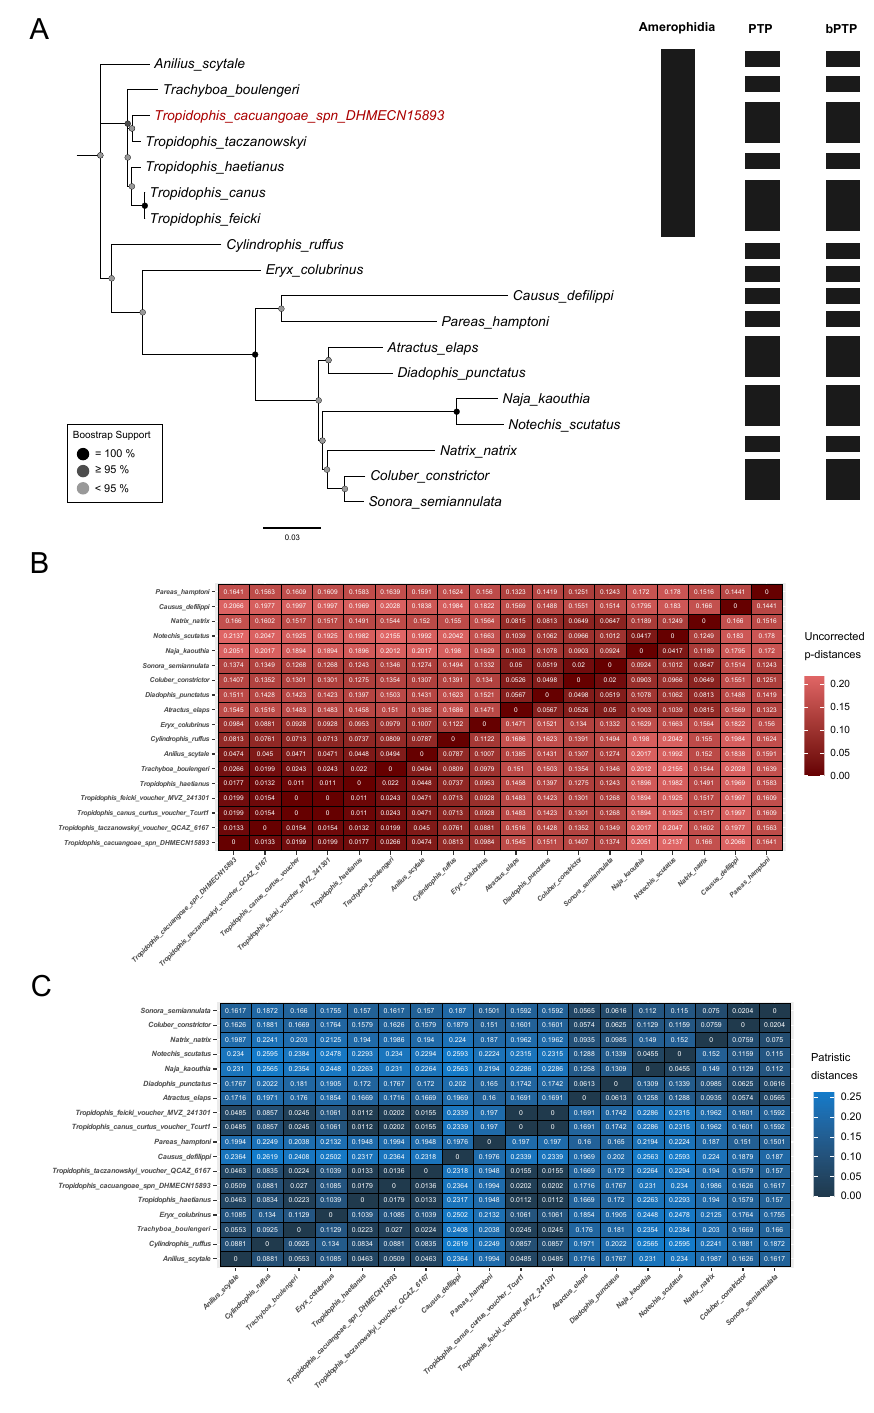
Fig. 2. Phylogenetic relationships of amerophid snakes, based on nuclear data. A . Maximum likelihood topology (lnL = -2175.559394), based on neurotrophin-3 gene fragments, scale bar of substitution rates, bars indicate Amerophidia clade, Poisson Tree Process (PTP) and Bayesian Poisson Tree Process (bPTP) coalescent-based species delimitation analyses. B . Uncorrected p-distances. C . Patristic distances as inferred for maximum likelihood